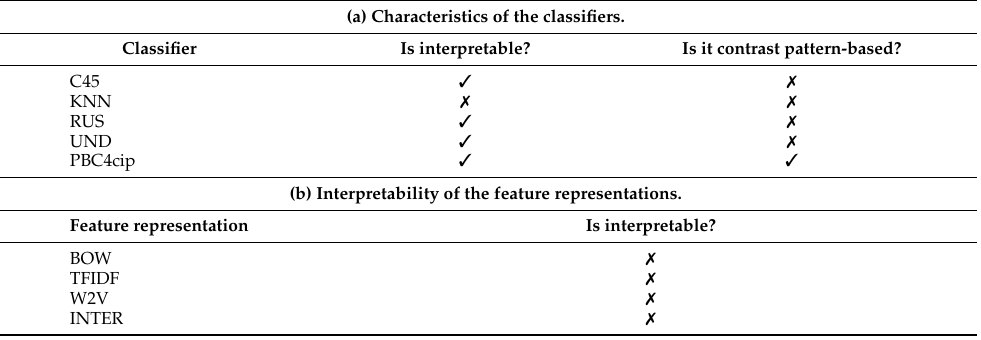
Table 8. Summary of the characteristics of the classifiers and the interpretability of the feature repre-